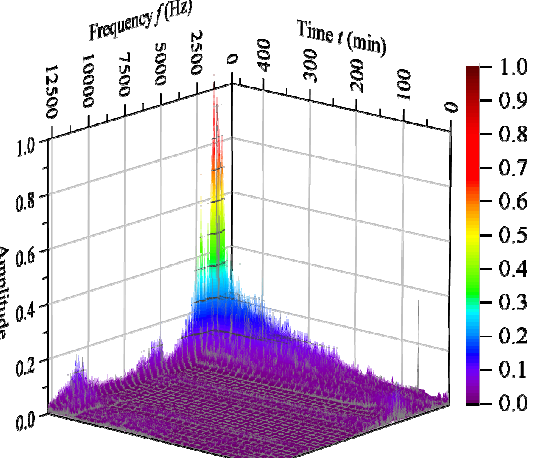
Figure 15. 3D diagram of the first bearing vibration data in time–frequency domain.